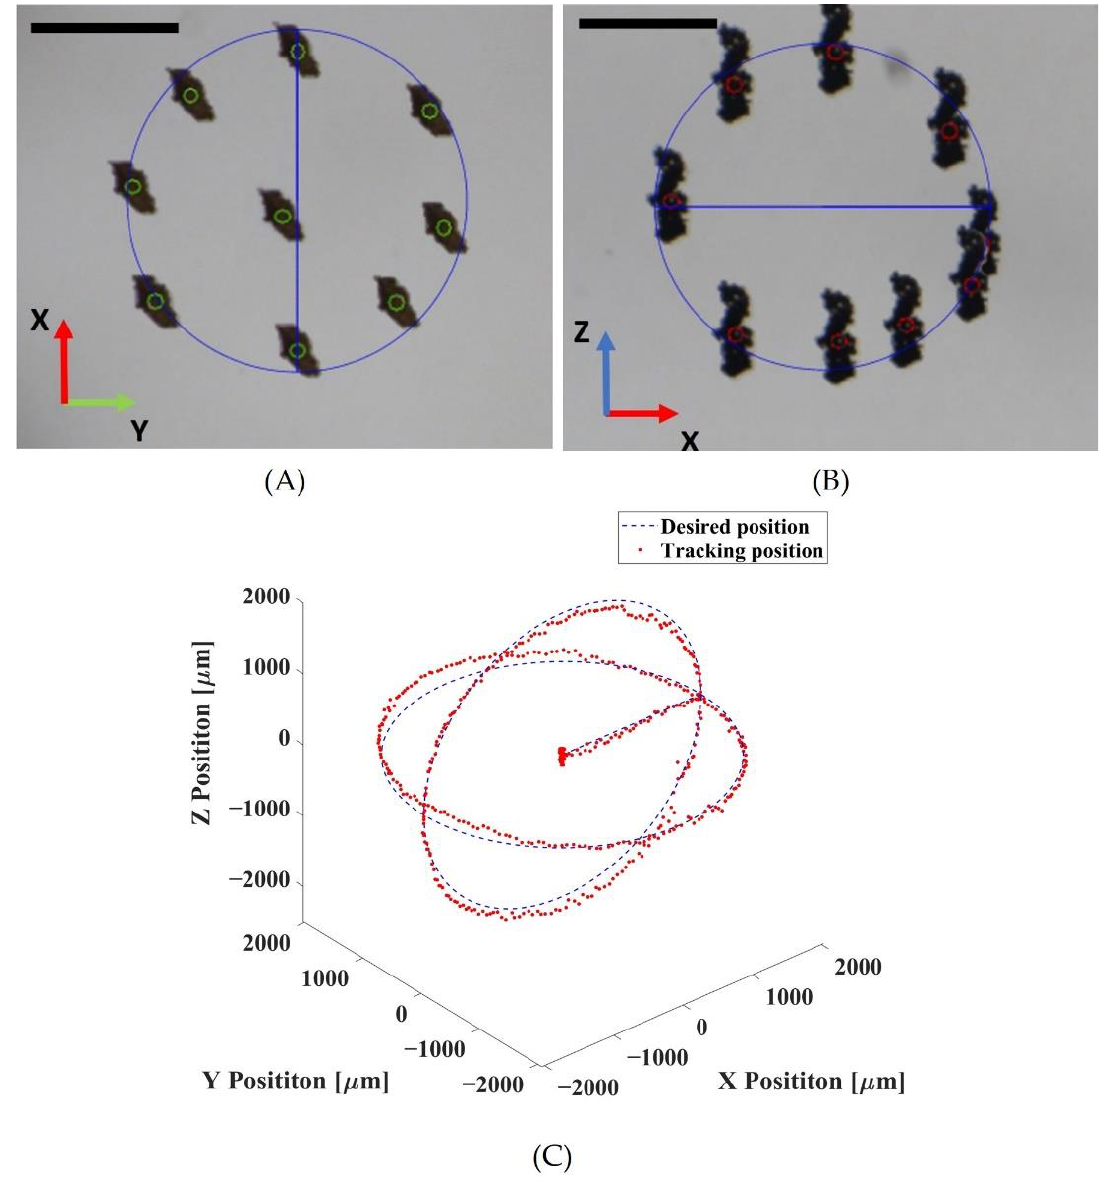
Figure 6. Demonstration of automated manipulation of Macbots following spherical trajectory: ( A ) time-lapse image sequence in O-XY view; ( B ) time-lapse image sequence in O-XZ view; ( C ) position tracking denoted by red dots corresponding to the desired position denoted by the blue dotted line (scale bar: 1 mm).